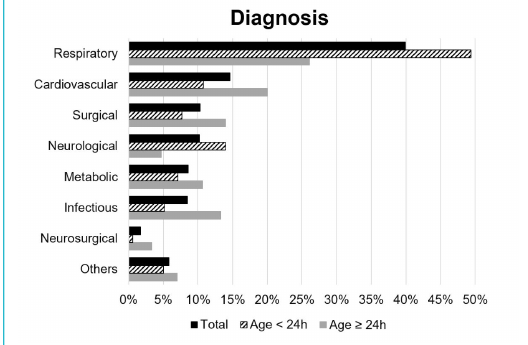
Figure 1: Medical problems requiring transport according to diag- nosis. Only the main reason for transport was